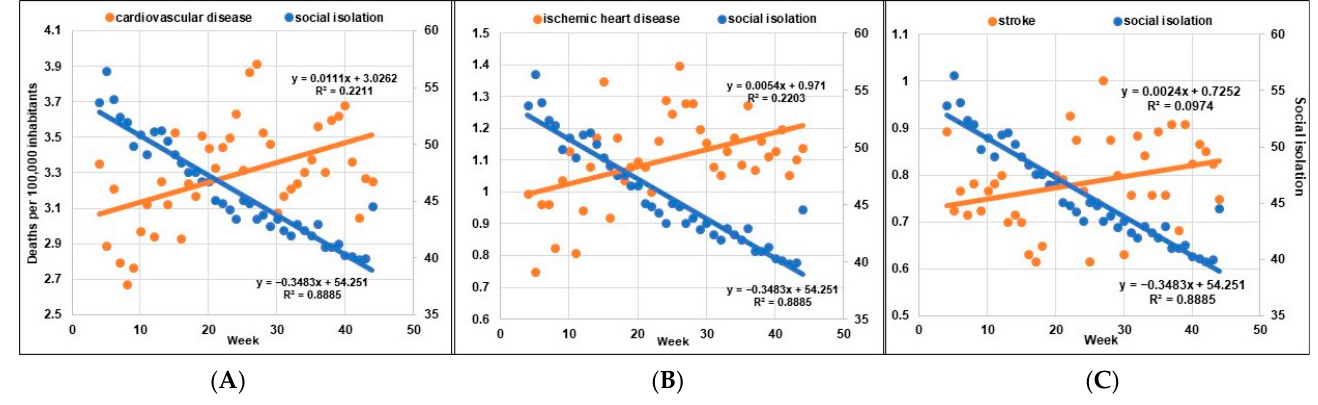
Figure 3. ( A ) Correlation between weekly social isolation and weekly deaths from cardiovascular disease; ( B ) Correlation between weekly social isolation and weekly deaths from ischemic heart disease; ( C ) Correlation between weekly social isolation and weekly deaths stroke.